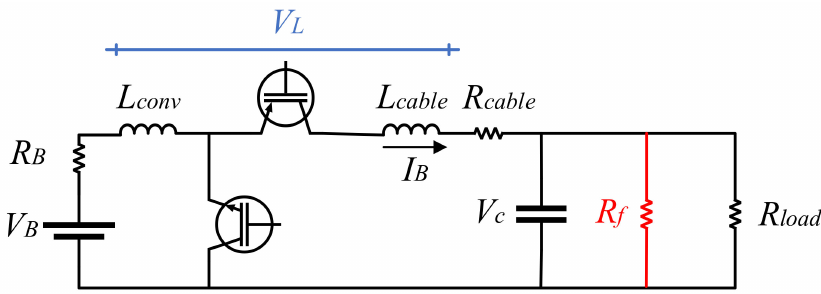
Figure 7. Equivalent ESS circuit during